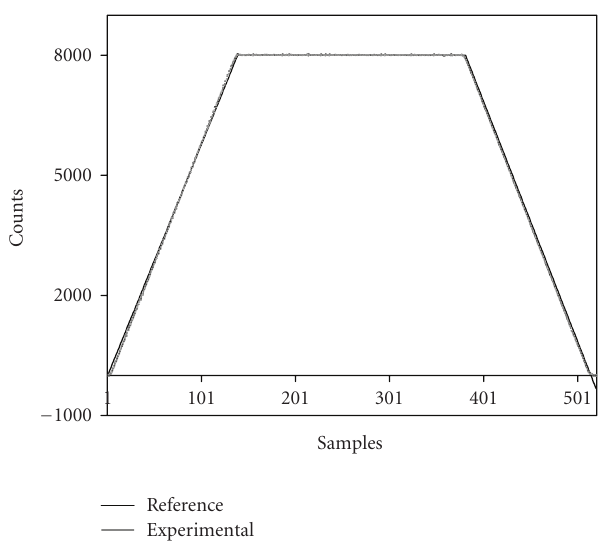
Figure 4: Experimental results for trapezoidal motion I.